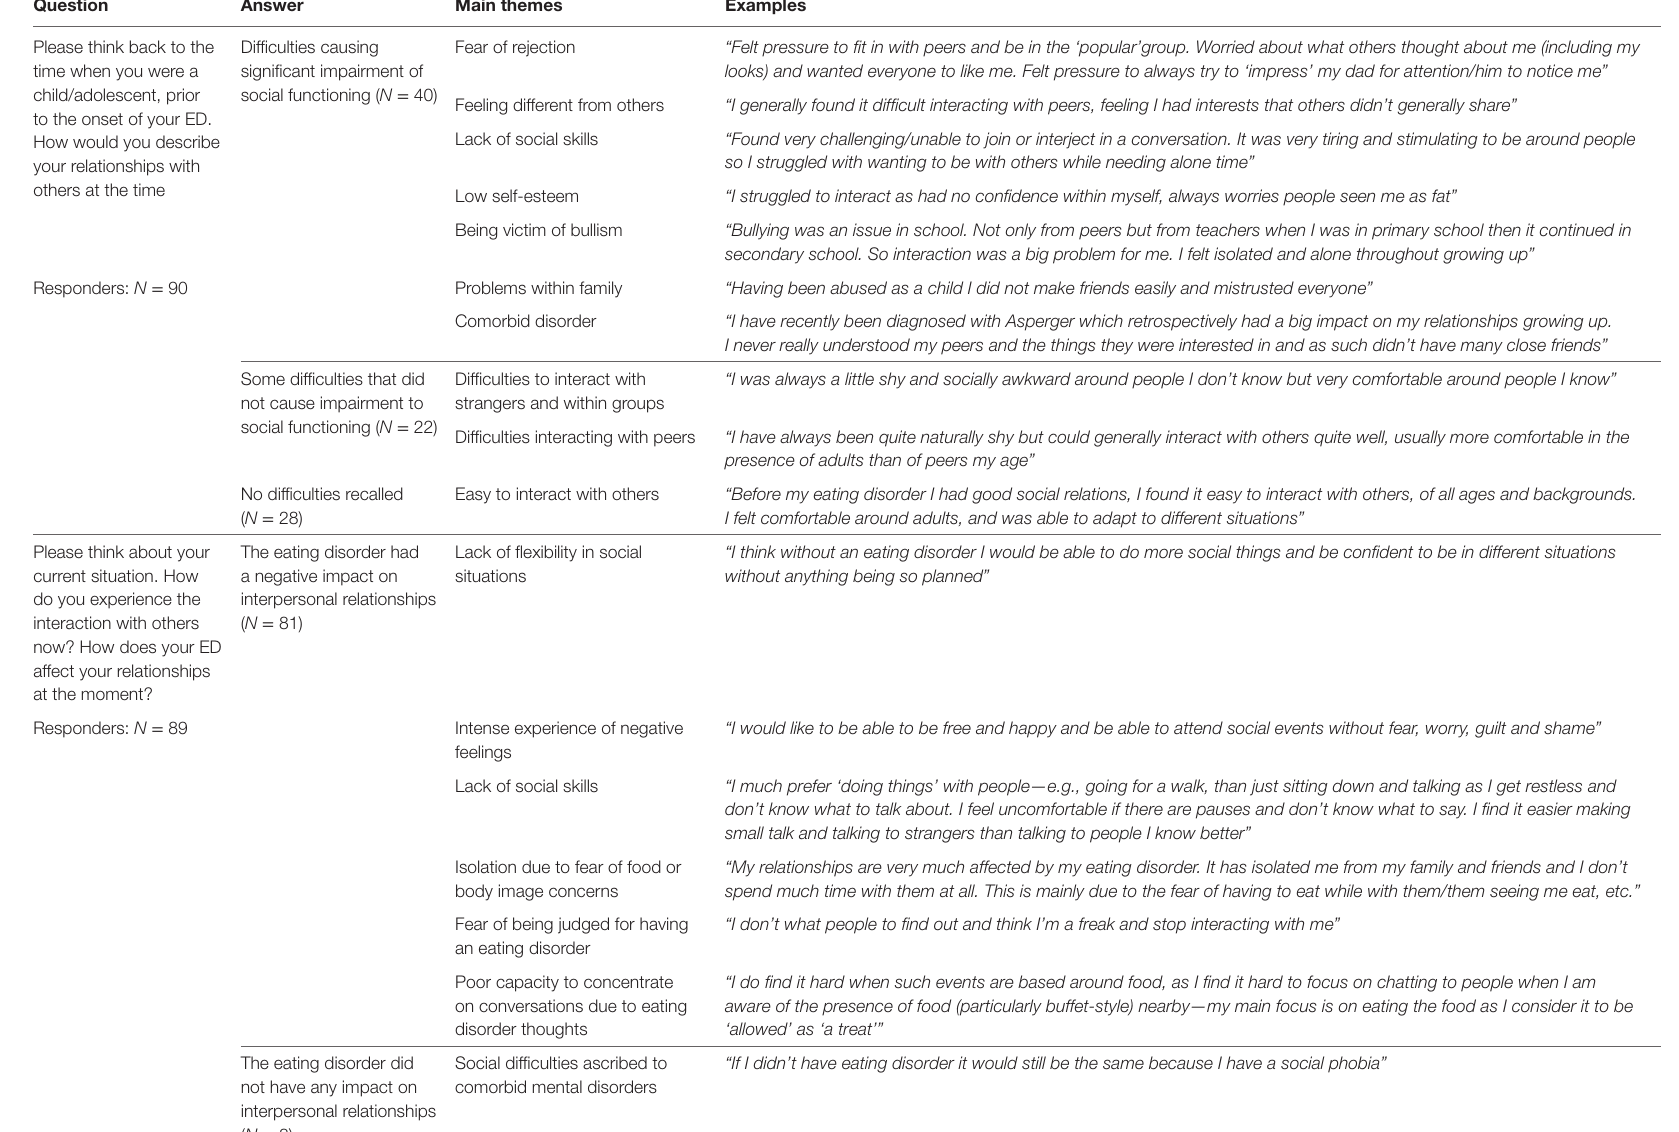
TaBle 3 | Main themes emerging in response to three open questions to investigate the quality of interpersonal relationships before and after illness onset, and the potential role that early social difficulties played in the development of the illness. Question answer Please think back to the time when you were a child/adolescent, prior to the onset of your